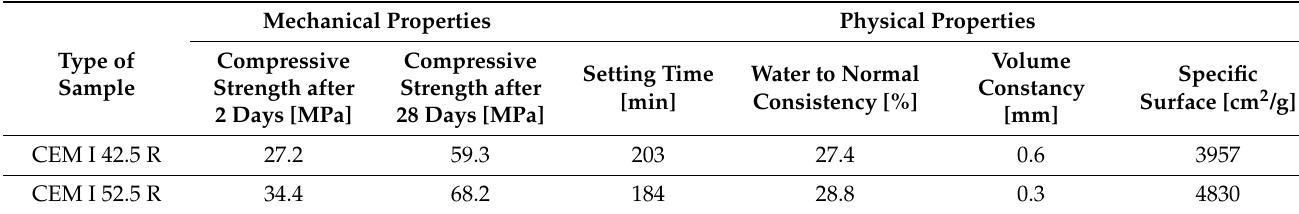
Table 3. Mechanical and physical properties of cement.